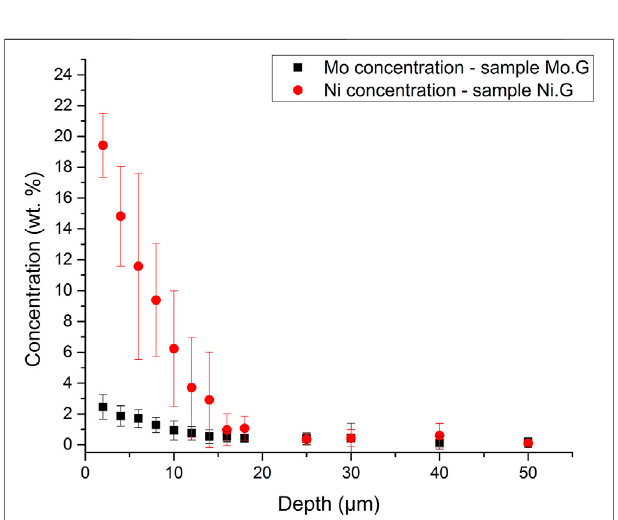
FIGURE 6 | Chemical composition pro fi les (EDS) of the cross section (error bars show standard deviation).